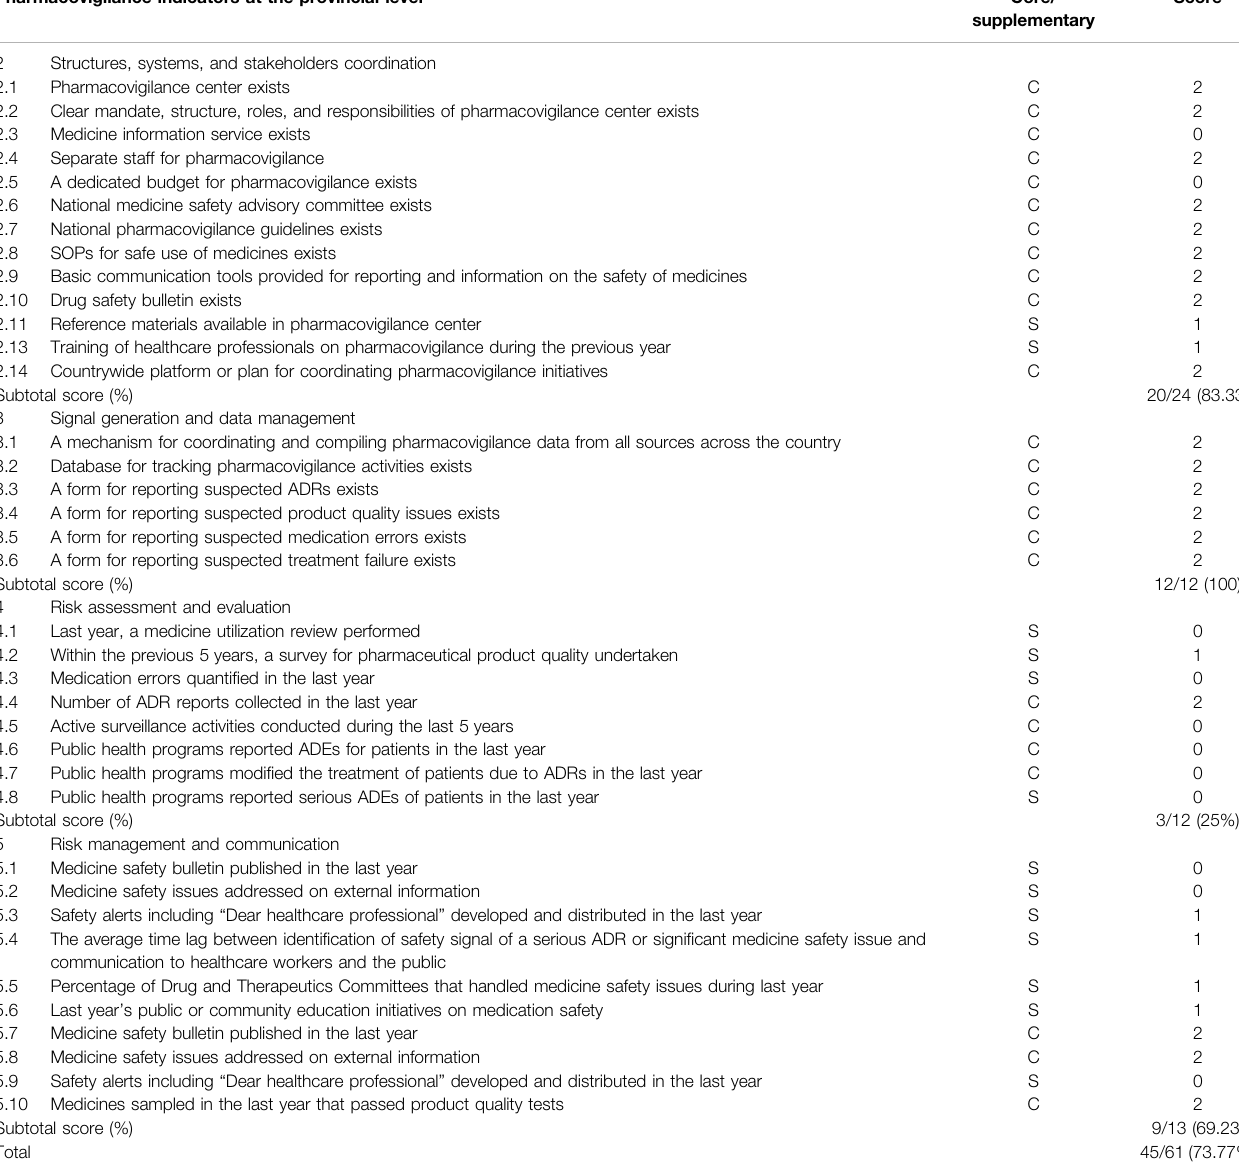
TABLE 3 | Primary and secondary healthcare department